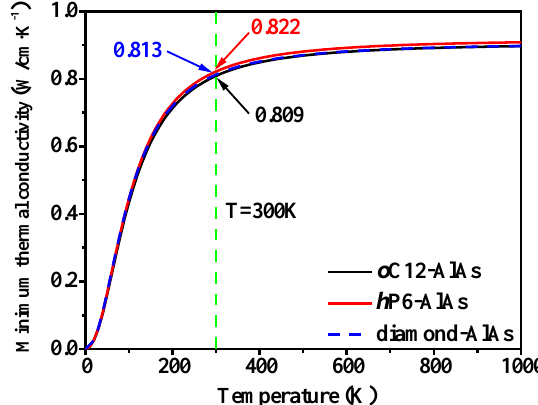
Figure 5. Temperature dependence of the minimum thermal conductivity for o C12-AlAs, h P6-AlAs, and diamond-AlAs at ambient pressure.